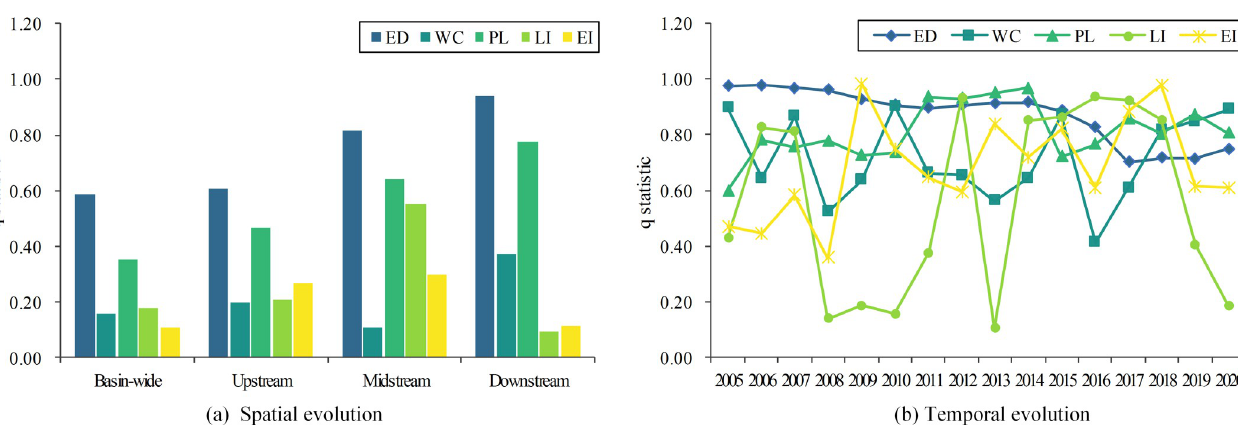
Fig 5. Spatial and temporal evolution of the driving force of internal